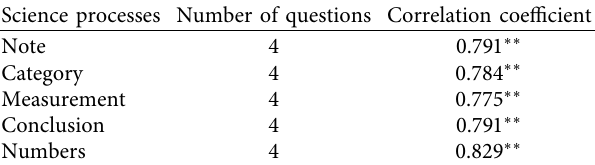
Table 4: Pearson’s correlation coefficient between the degree of each (operation) and the total score for the basic science process test.